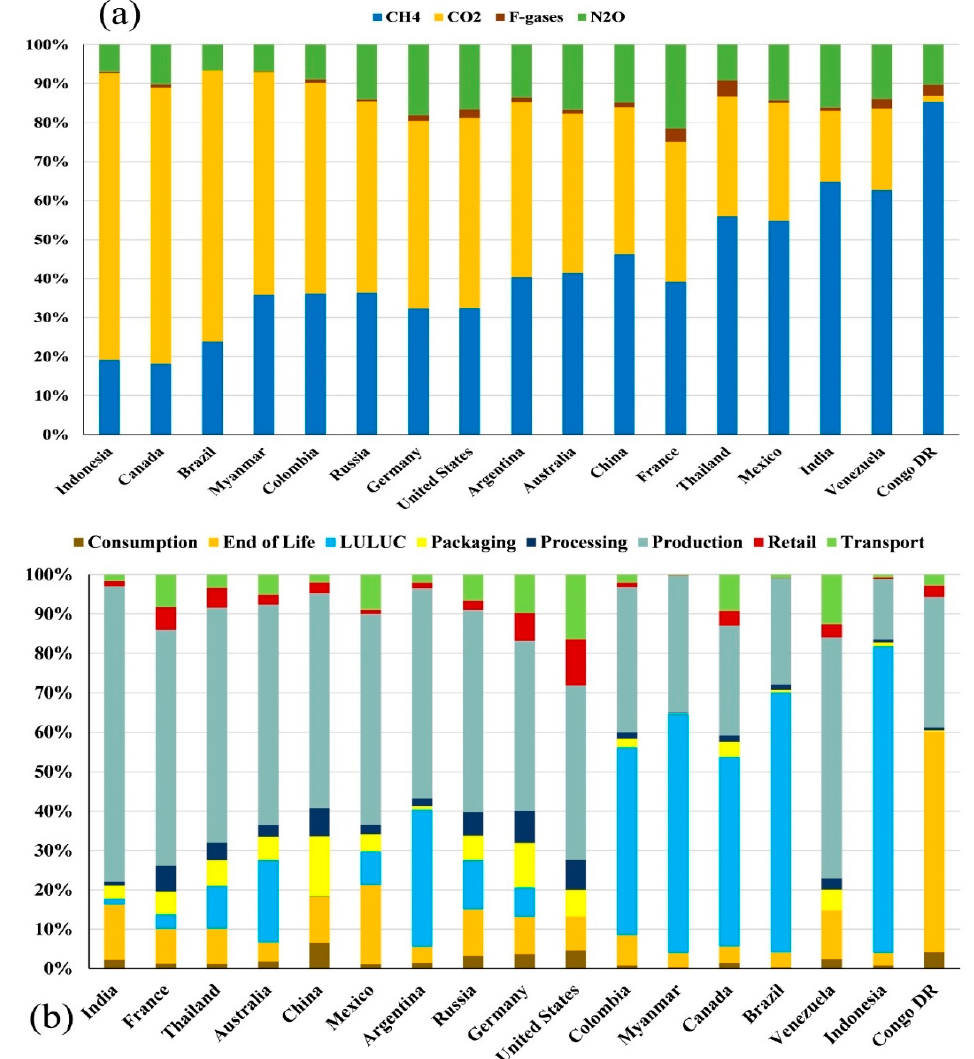
Figure 5. Distribution of GHG emissions for the 17 nations of highest historical responsibility (>1%). It shows the share (%) of total historical emissions. ( a ) GHG emissions from four substances—CH 4 , CO 2 , F-gases, and N 2 O. ( b ) GHG emissions from eight sectors—Consumption, End of Life, LULUC (Land Use and Land-Use Changes), Packaging, Processing, Production, Retail, and